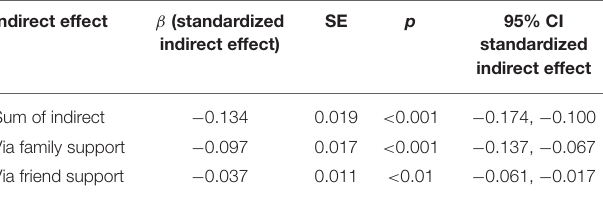
TABLE 2 | Standardized indirect effects from psychological suzhi to suicide ideation. Indirect